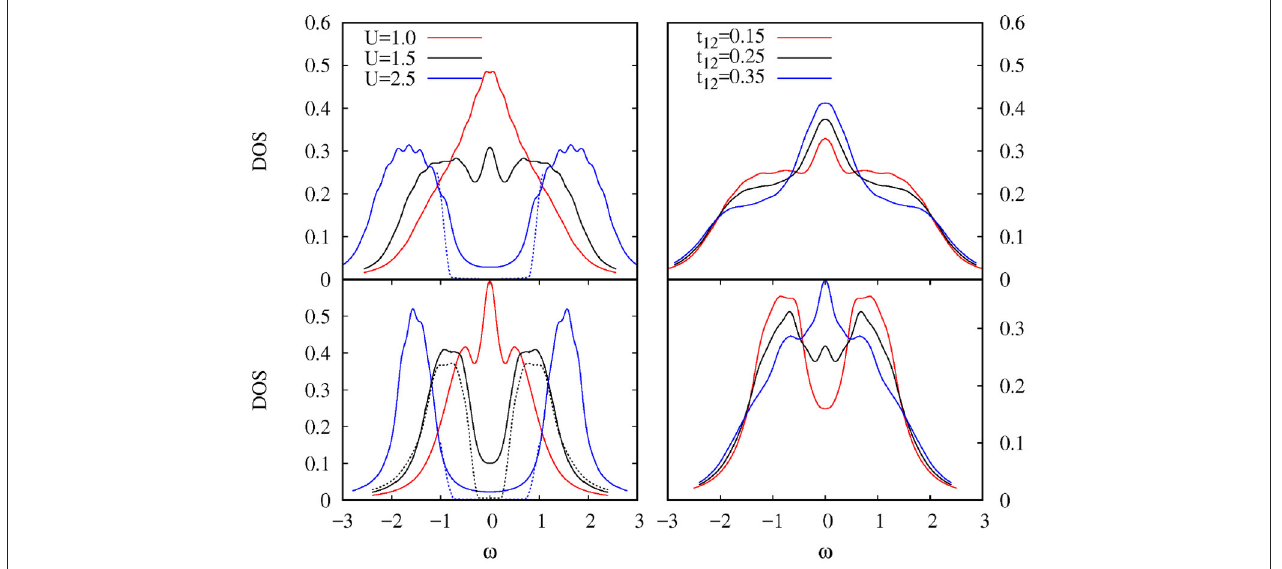
1.5. We consider the rotationally =